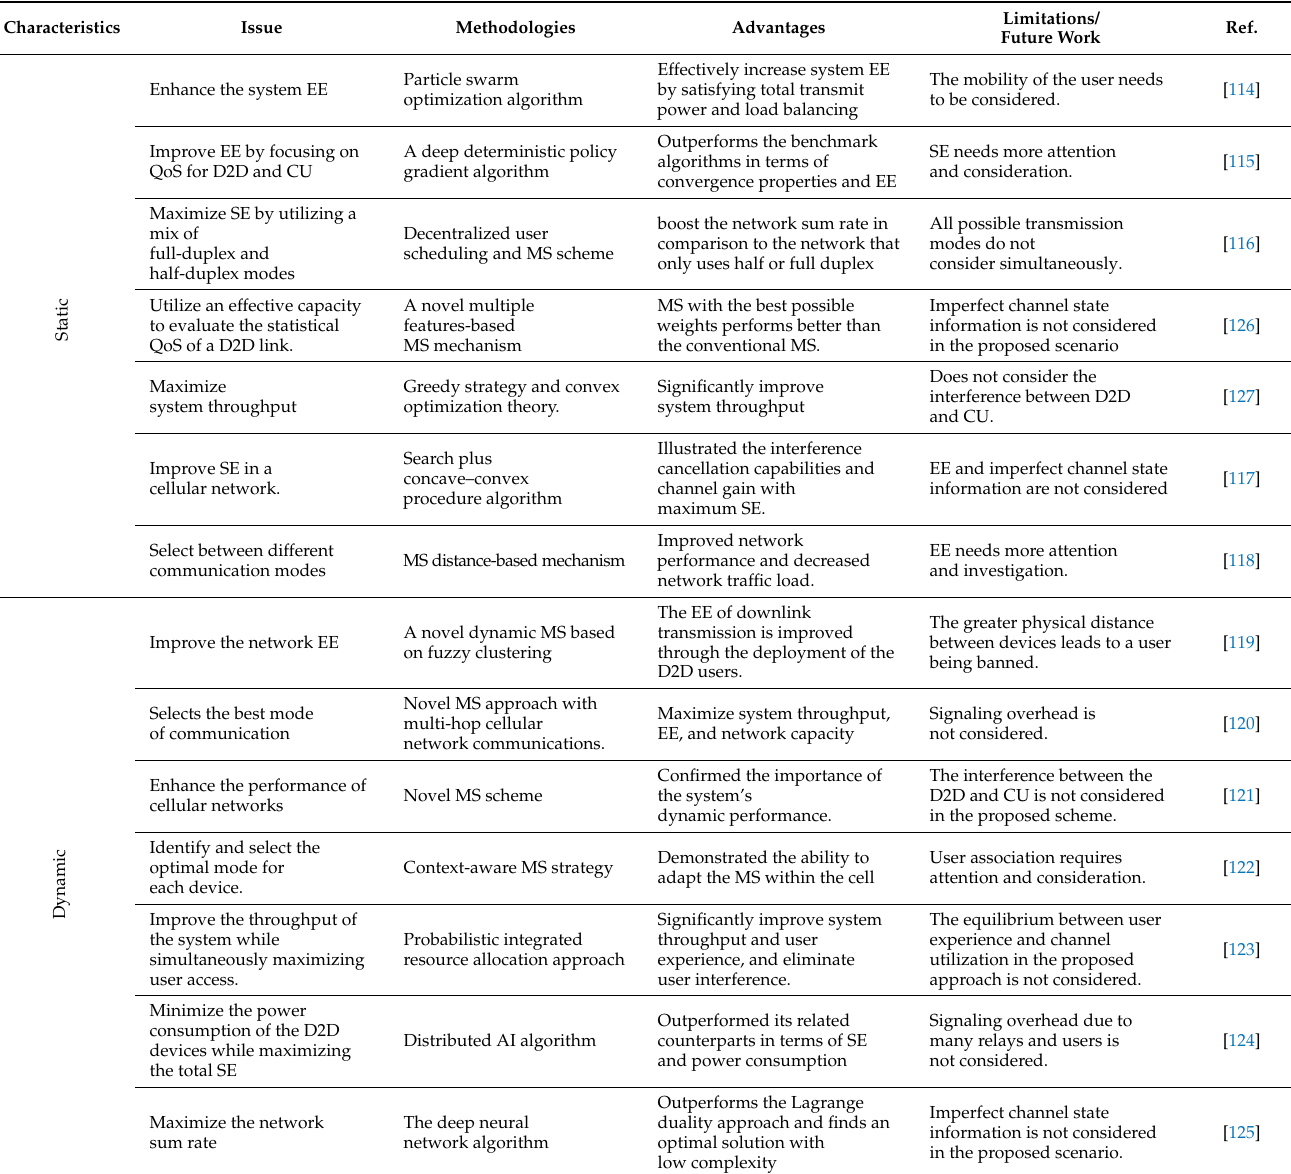
Table 4. Summary of the related work for mode